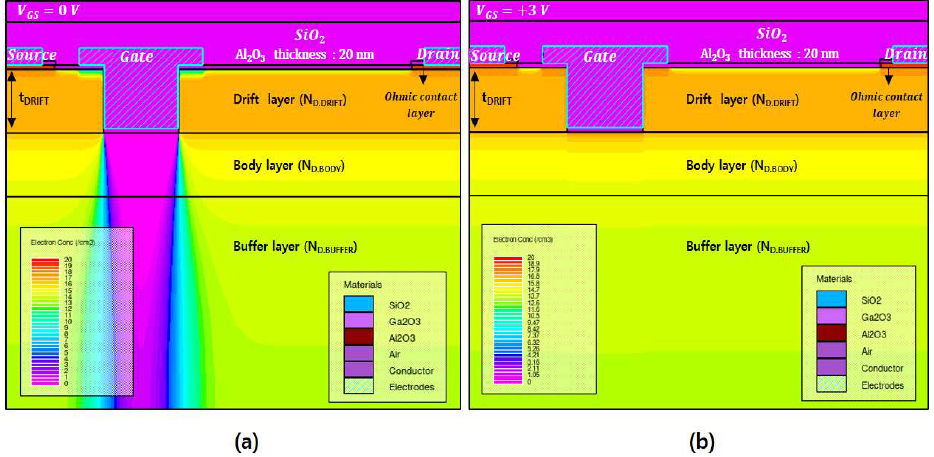
Figure 2. Electron density distributions simulated with a gate voltage of ( a ) V GS = 0 V and ( b ) V GS = +3 V.